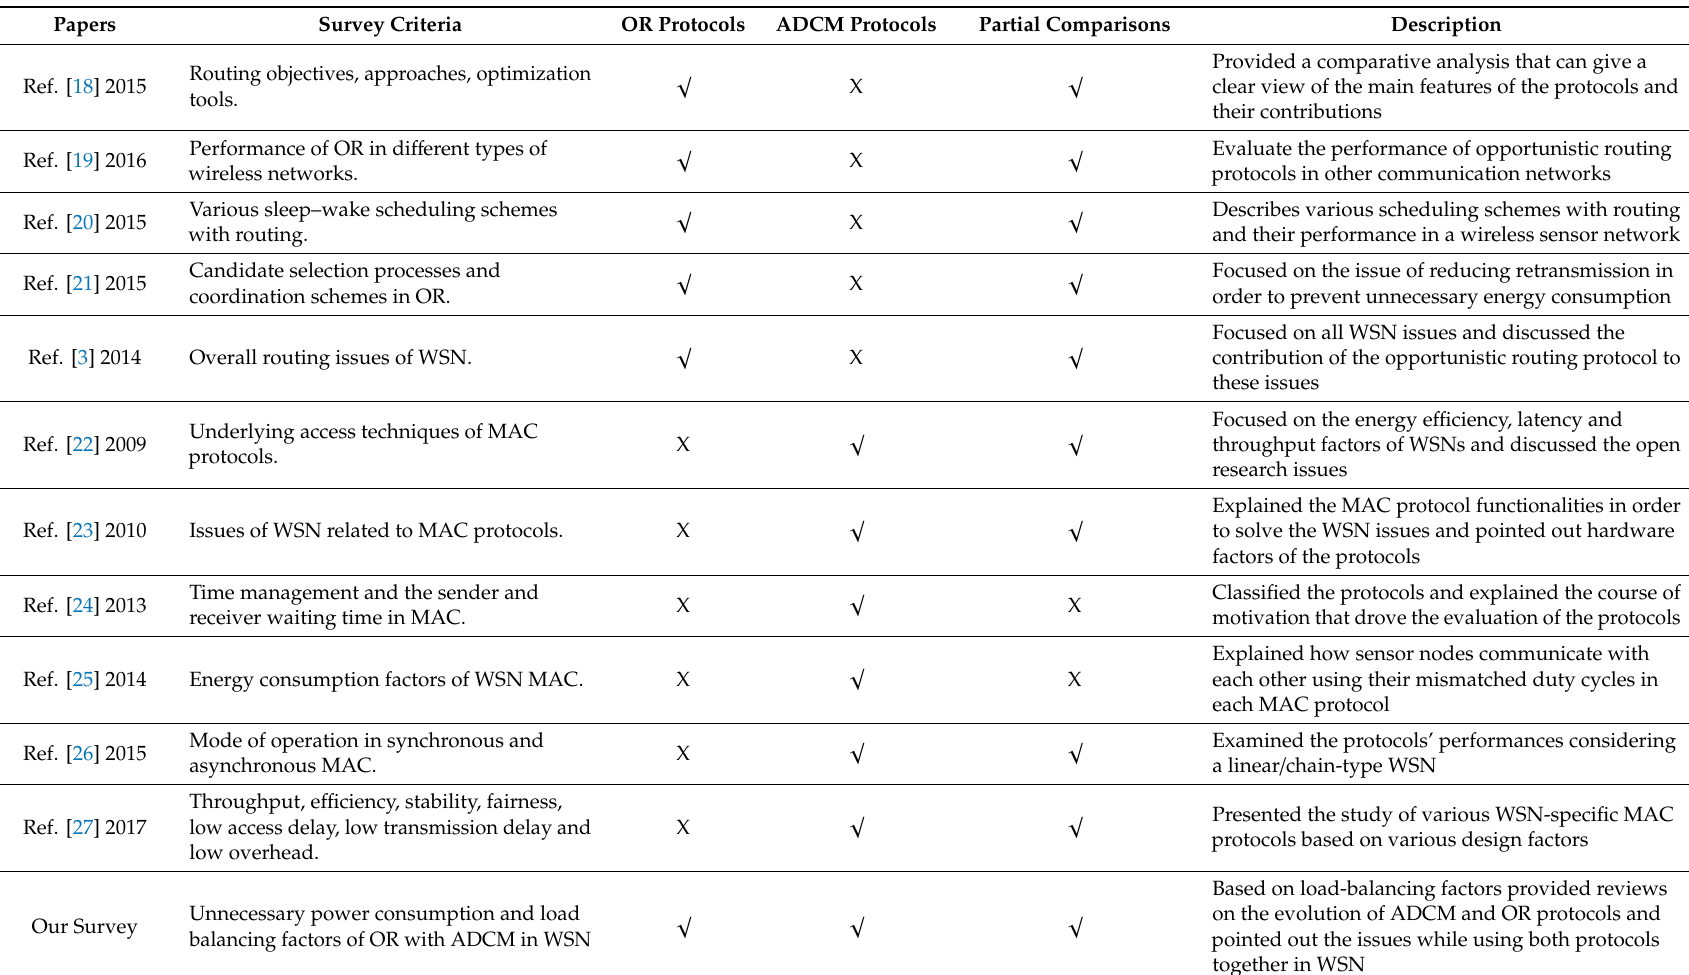
Table 1. Previous survey related works at a